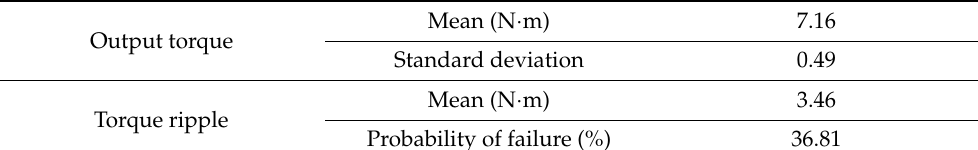
Table 4. Reliability analysis of the BLDC motor.